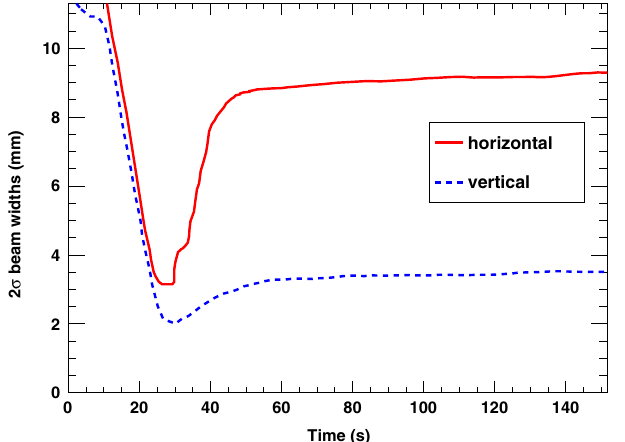
FIG. 21. Widths 2 σ from fits to beam profiles measured with the ionization profile monitor (IPM) vs the time after injection to COSY ( < 25 s: electron cooling, 25 – 50 s tilting the electron beam with respect to the proton beam, > 50 s increased equi- librium beam size). The corresponding horizontal beam profile is shown in Fig. 10.